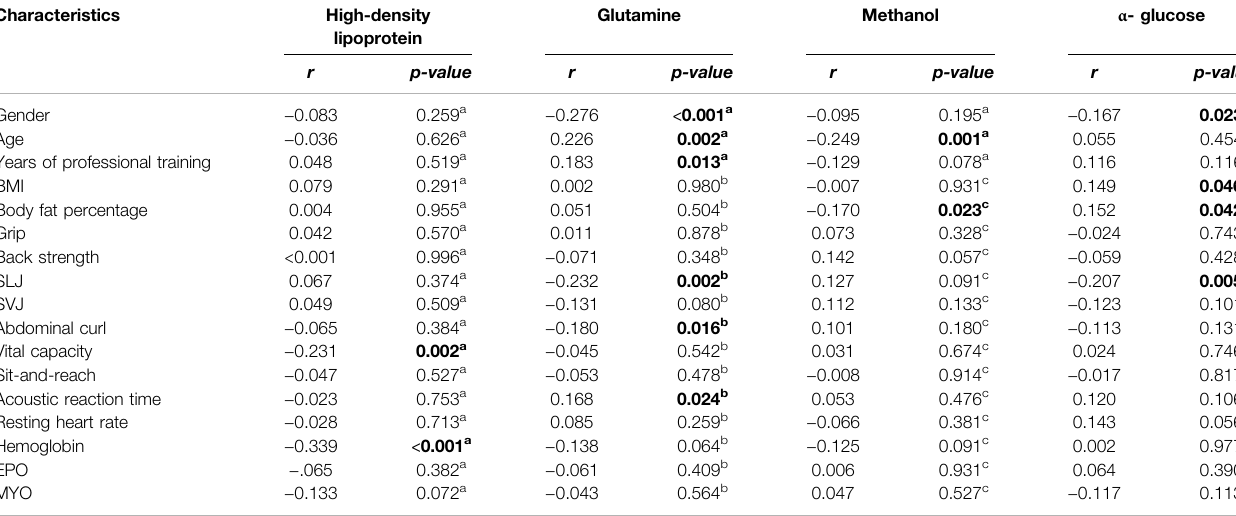
TABLE 3 | Correlation analysis between four signi fi cant serum metabolites and baseline characteristics. Characteristics